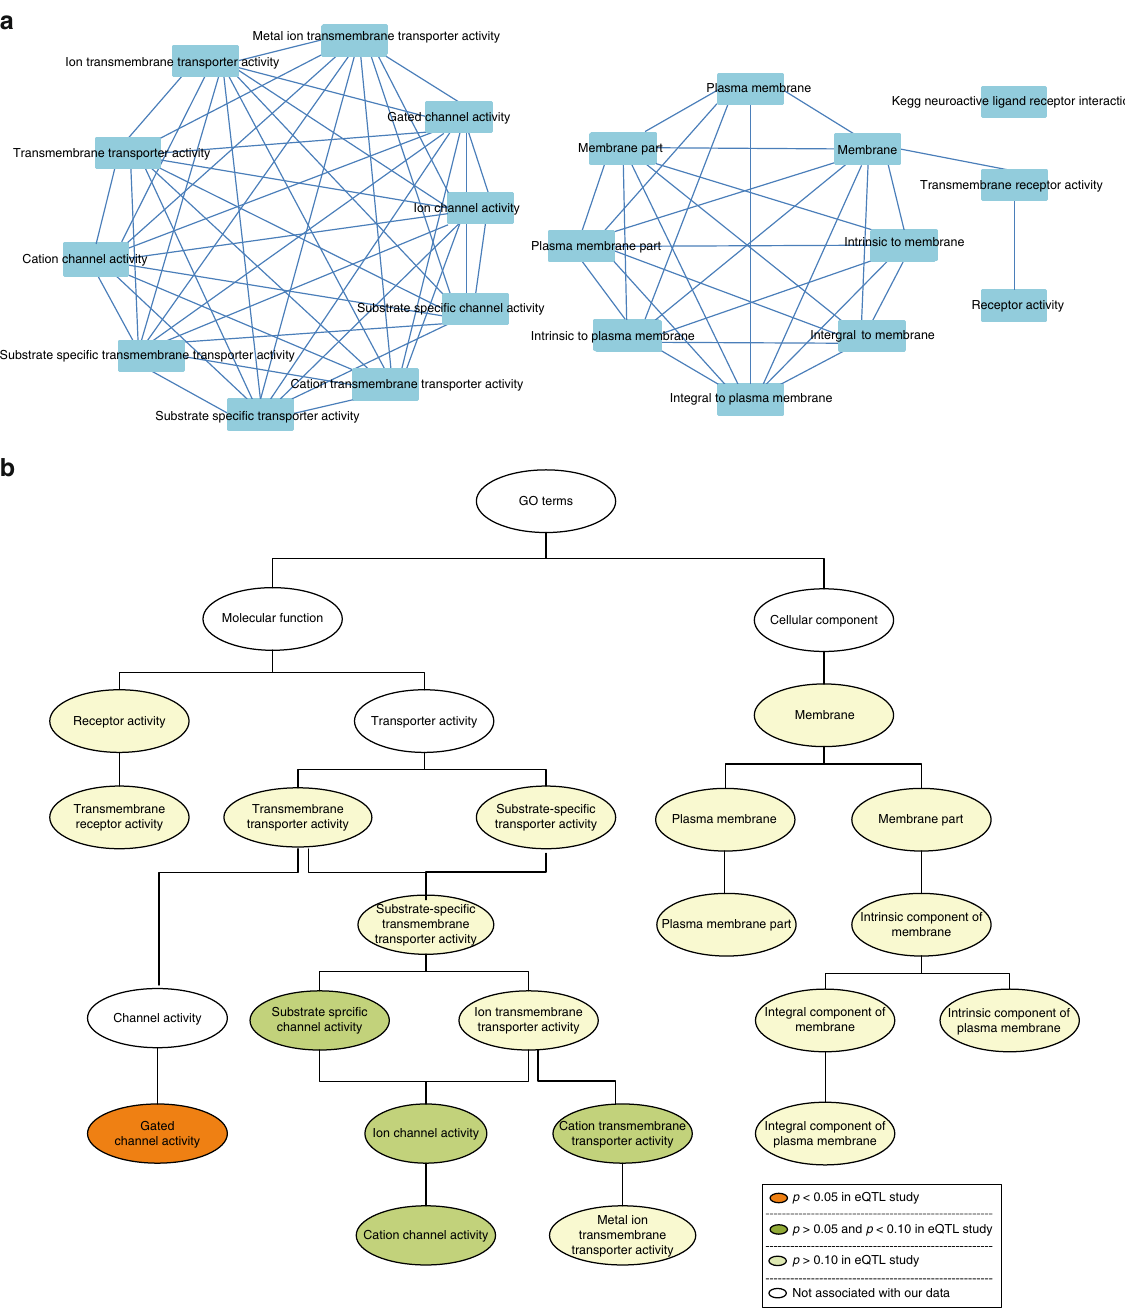
Fig. 3 Association among susceptibility pathways and GO terms. a Each node is a subcomponent. Connecting lines are drawn if the overlapping coef fi cient between the two nodes is greater than 0.8. This picture was drawn by Cytoscape with EnrichmentMap plugin, using the standard gene set fi le. b The relationship between the susceptibility GO terms. The relationship between the GO terms was based on the knowledge from the European Bioinformatics Institute. All gene sets which were enriched in our GWAS pathway analyses were colored. Of the GO terms, 10 terms belonged to a transporter activity term. Both substrate-speci fi c transporter activity term and transmembrane transporter activity term are part of the transporter activity term and have a child term of substrate-speci fi c transmembrane transporter activity. Both terms of substrate-speci fi c channel activity and ion transmembrane transporter activity are part of the substrate-speci fi c transmembrane transporter activity term, and have a child term of ion channel activity which had a child term of cation channel activity. In addition, cation transmembrane transporter activity was part of ion transmembrane transporter activity, and had a child term of metal ion transmembrane transporter activity. Gated channel activity term was a child term of transmembrane transporter activity and shared several child terms with ion channel activity